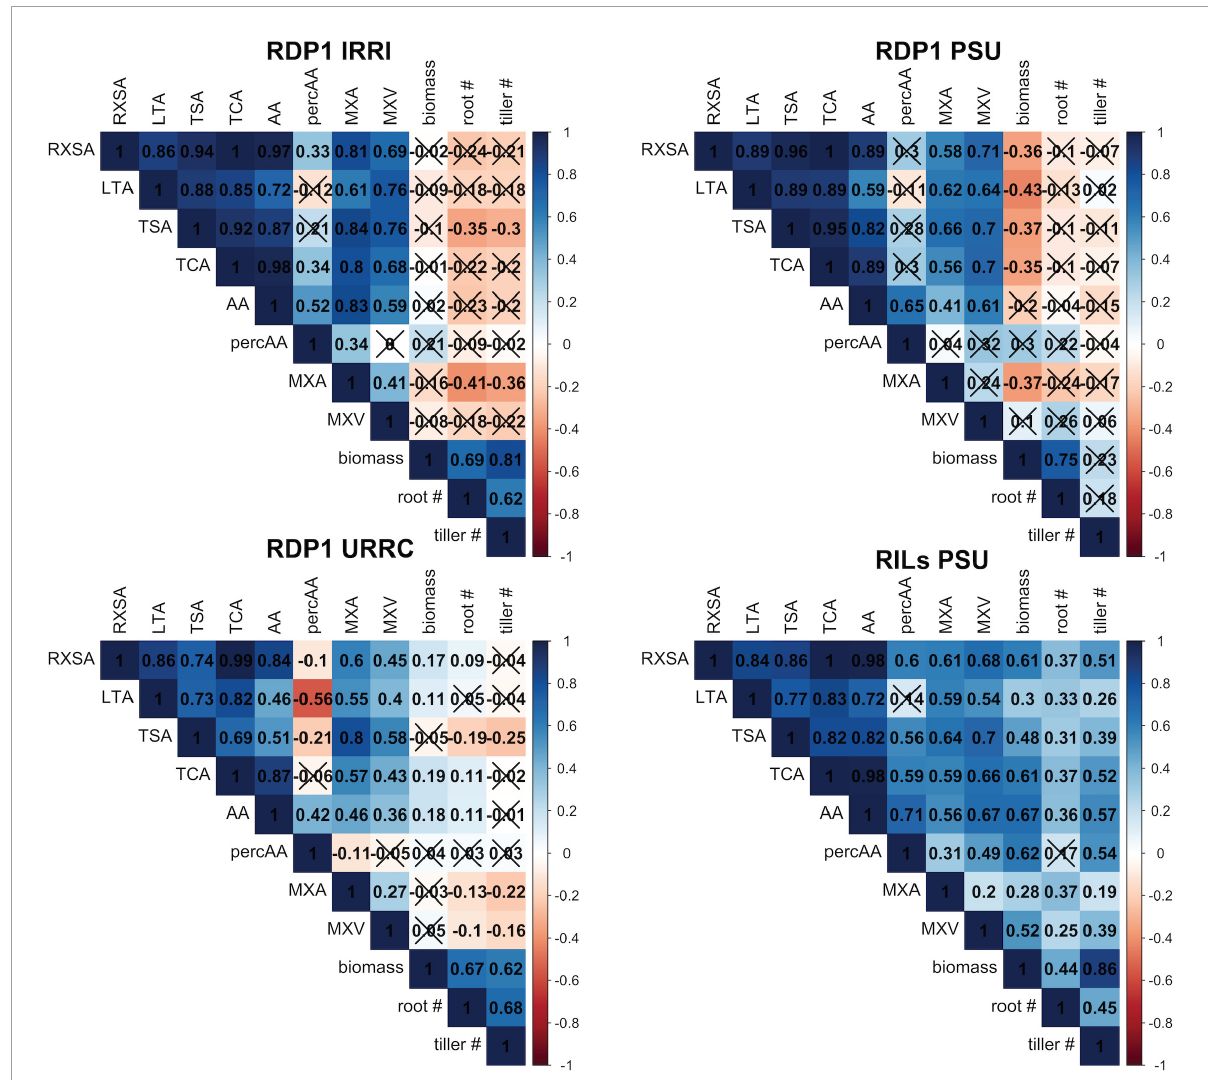
FIGURE1 Correlation matrices by experiment. Correlation matrices of root anatomical traits, shoot dry biomass, nodal root number, and tiller number under drought stress within each experiment location. Each box shows the correlation coefficient, r , between each trait. X’s indicate that the correlation was not significant at the α = 0.1 level. See Table 1 for phenotype